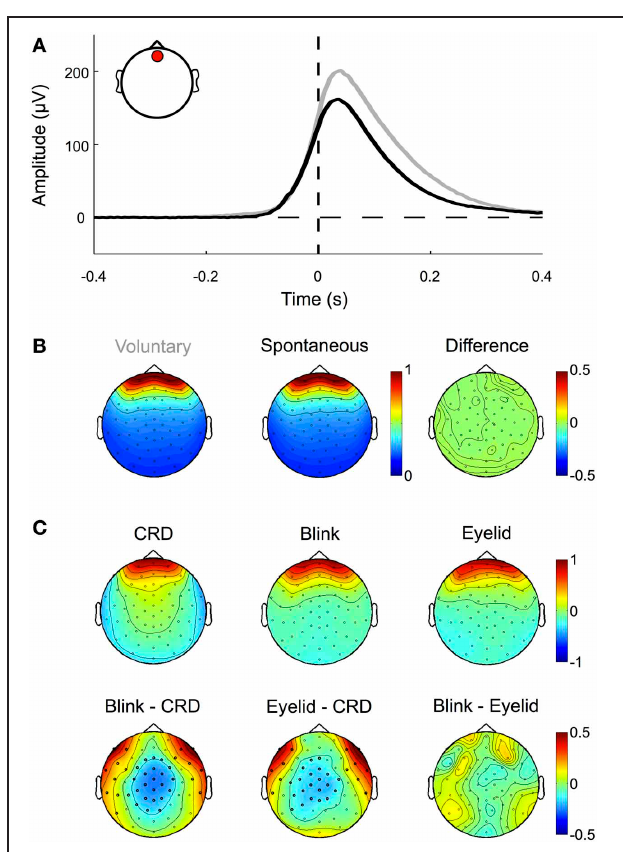
FIGURE 5 | Eyelid-induced signal changes. (A) ERP traces for voluntary (gray) and spontaneous (black) blinks measured at a frontal electrode (inset, red circle). Voluntary blinks are of longer duration and result in higher amplitudes than involuntary blinks. Note that blink onset as defined by the eye tracker (time 0, vertical dashed line) corresponds to the point at which the pupil is not visible anymore. The actual eyelid movement already starts around 100ms earlier, when the signal deflects from the zero line (horizontal dashed line). (B) Although spontaneous and voluntary blinks differ in amplitude and duration, they share the same topographic pattern (i.e., the normalized amplitude distribution across the scalp). (C) Topographic patterns of corneo-retinal dipole offsets related to upward saccades, blinks, and post-saccadic eyelid movements (upper row) and the differences between them (lower row). Bold black dots indicate electrode sites with statistical significant differences. The results show that corneo-retinal dipole offsets produce a topographic pattern that differs from both, blinks and post-saccadic eyelid movements, while no differences were found between the latter two. This suggests that blinks and post-saccadic eyelid movements are produced by the same electrophysiological